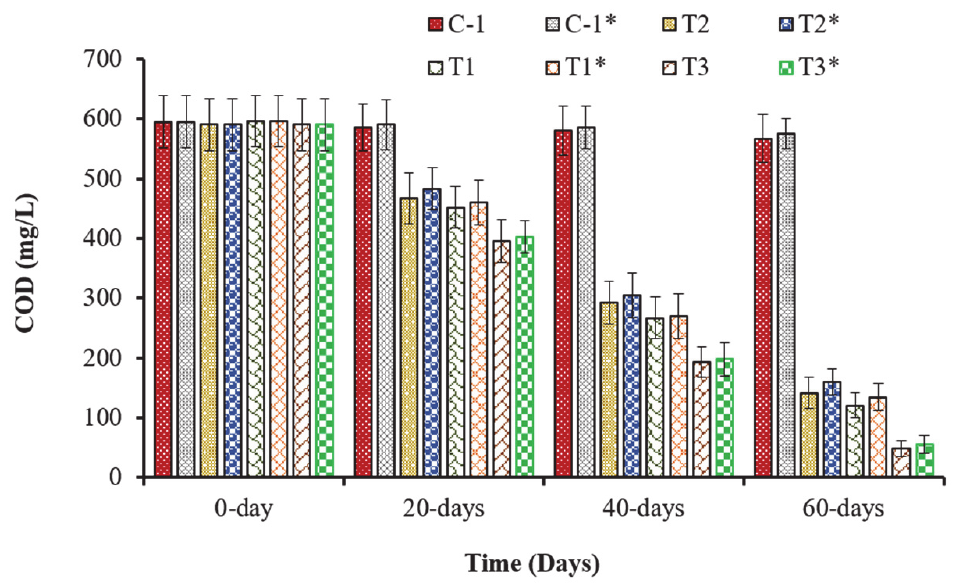
Figure 5. COD reduction in CW and FTW vegetated with Phragmites australis.